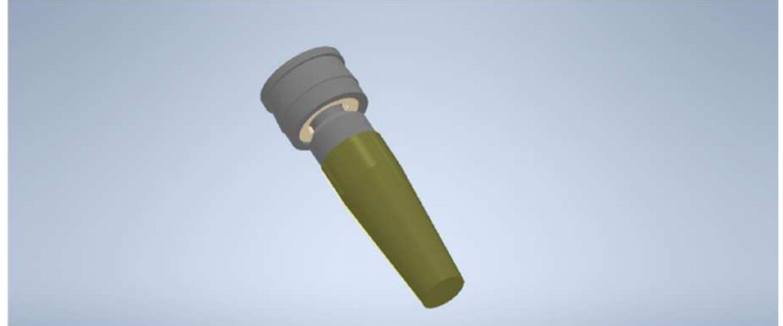
Figure 3. The 3D Model of the implant and ball attachment, with matrix housing.